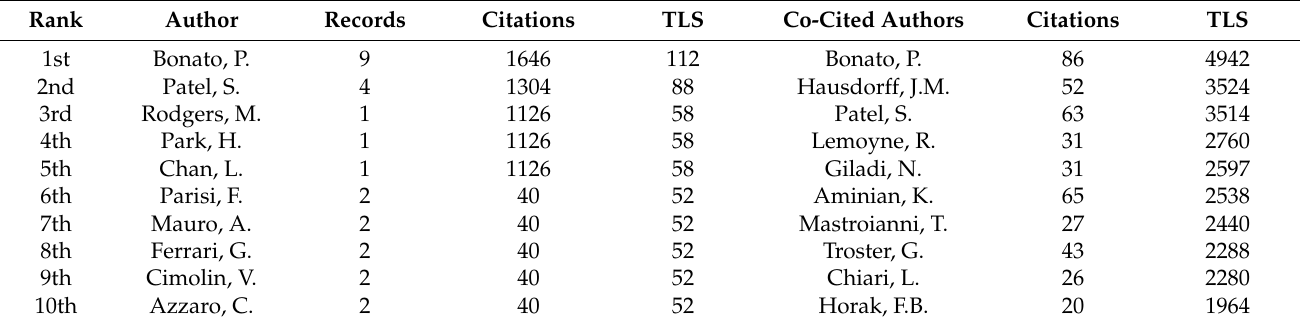
Table 5. The top 10 most influential authors and co-cited authors on